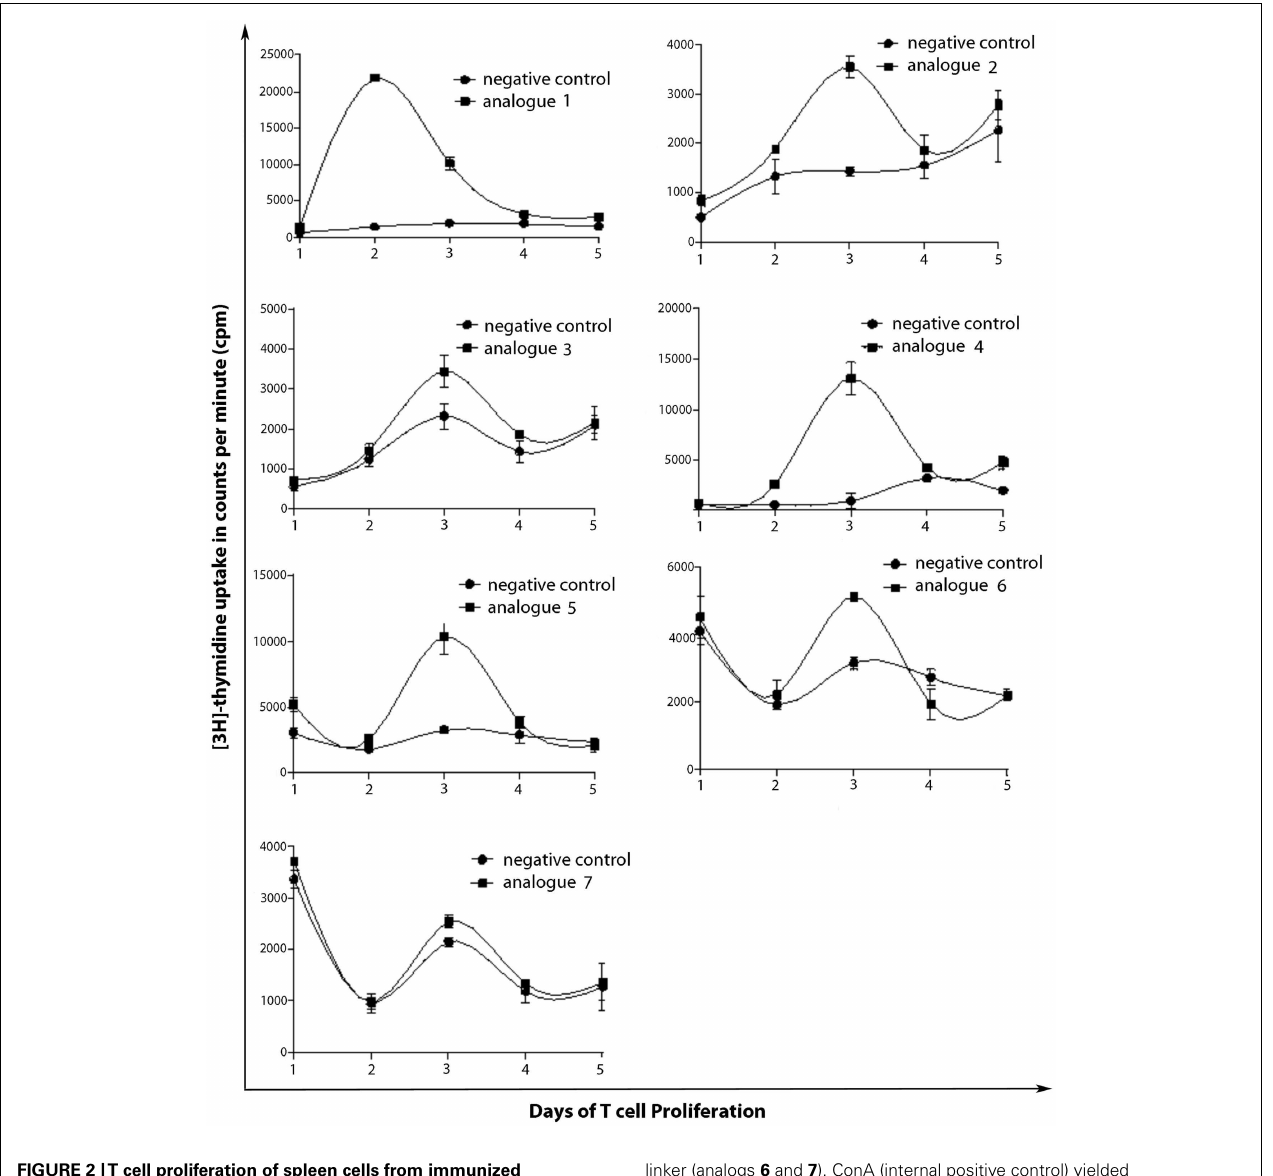
FIGURE 2 |T cell proliferation of spleen cells from immunized mice . SJL/J mice were immunized using linear MBP 83–99 analogs conjugated to reduced mannan via (KG) 5 bridge (analogs 1–5 ) and cyclic MBP 83–99 analogs conjugated to reduced mannan via KLH